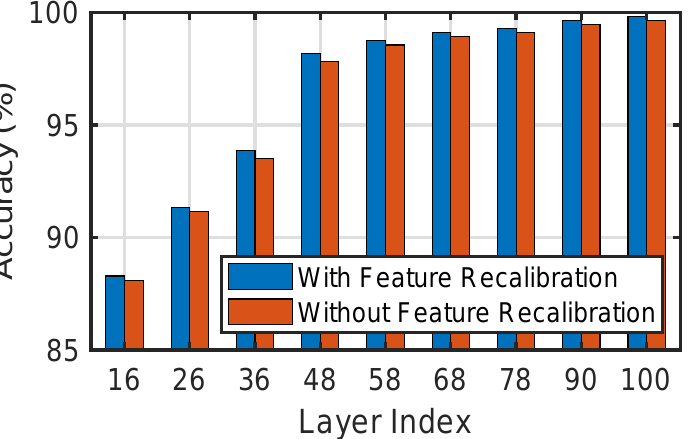
Figure 4. Recognition performance comparison of our method with and without feature recalibration on Flavia dataset under different layers of